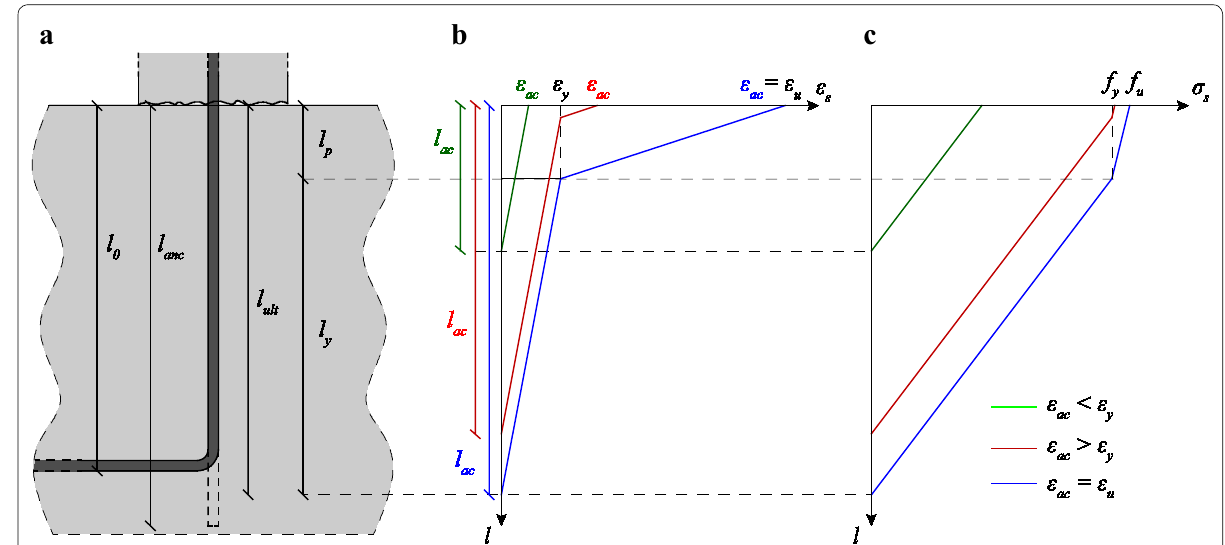
Fig. 4 Anchorage-slip element for bent anchored bars with l anc > l ult : a Sketch of the anchorage detail. b Qualitative steel strain profiles. c Qualitative steel stress profiles.